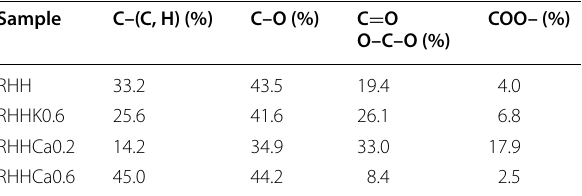
Table 2 Relative atomic concentration of C in the selected hydrochars Sample